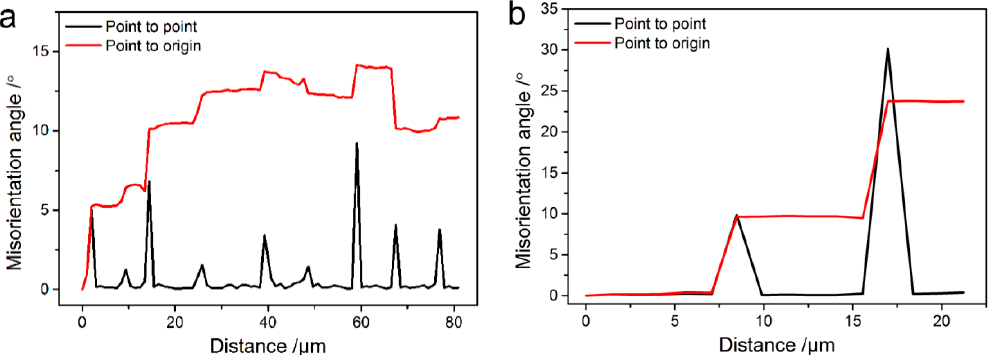
Figure 8. Misorientation profiles obtained along the lines marked in Figure 6b. ( a ) L3; ( b ) L4.